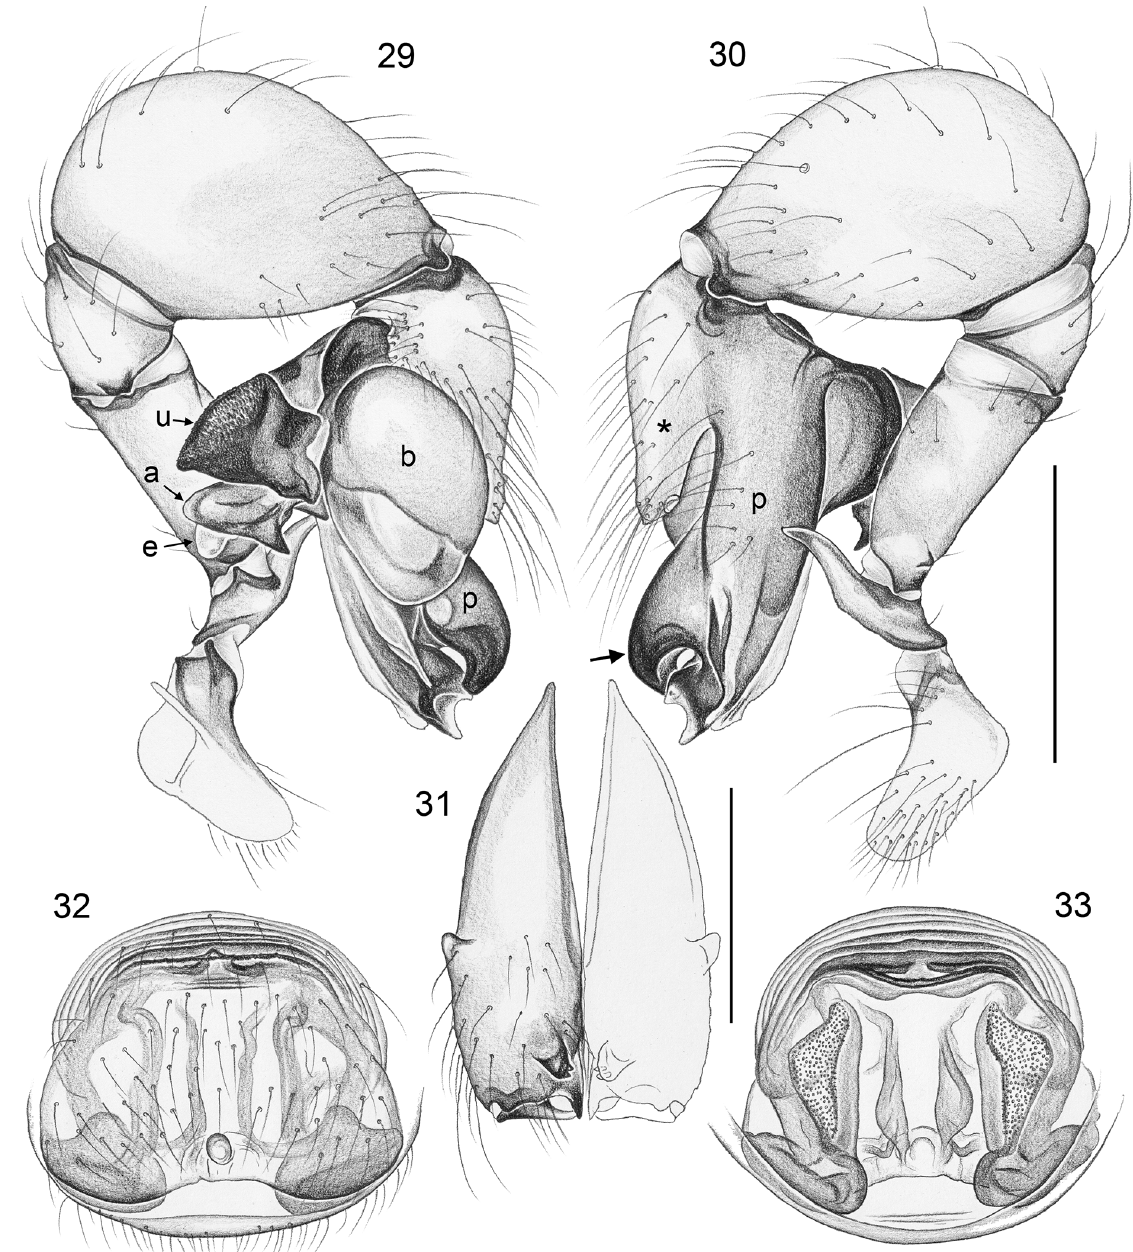
Figs 29–33. Pholcus ubin Huber, sp. nov., ZFMK Ar 15011. 29–30 . Left male palp, prolateral and retrolateral views (arrow points at distinctive dorsal process; asterisk marks dorsal elongation of male palpal tarsus). 31 . Male chelicerae, frontal view. 32–33 . Cleared female genitalia, ventral and dorsal views. Abbreviations: a = appendix; b = genital bulb; e = embolus; p = procursus; u = uncus. Scale lines: 0.3 mm (31); 0.5 mm (29–30,